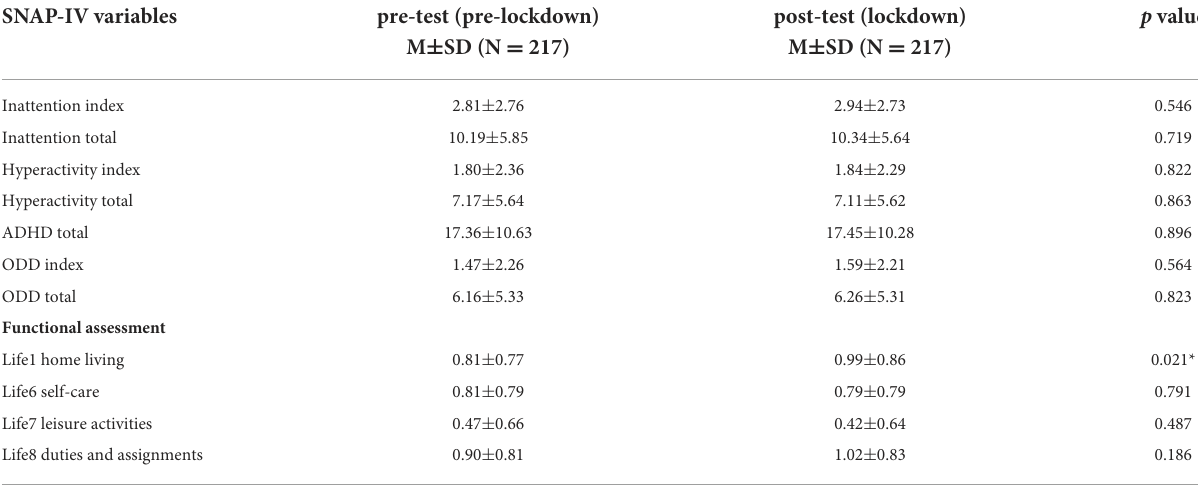
TABLE 3A Comparison of SNAP and the functional assessment during the lockdown and pre-lockdown periods.